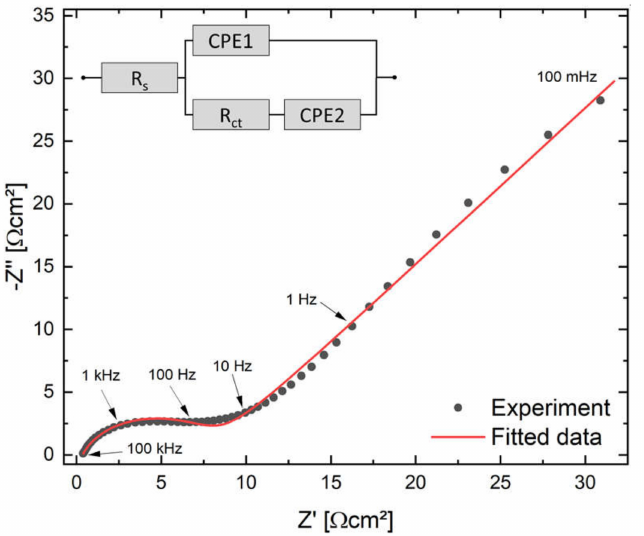
Figure 12. Nyquist plot of the FTO-PANI supercapacitor at E DC = 0.5 V. The inset displays the equivalent circuit for the